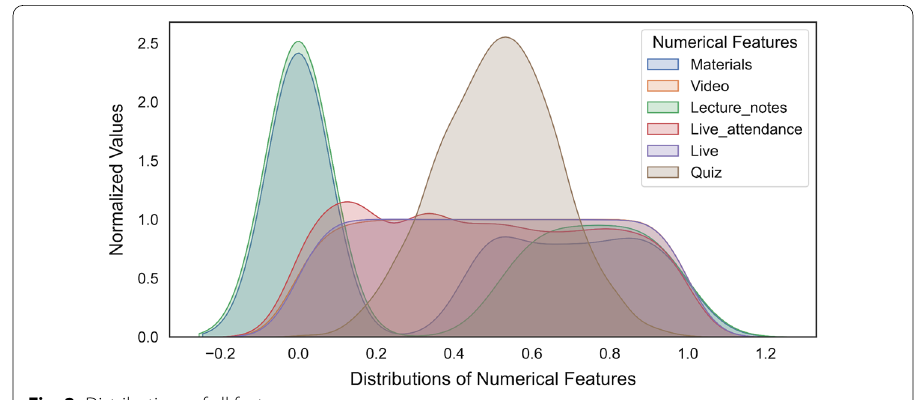
Fig. 2 Distributions of all features